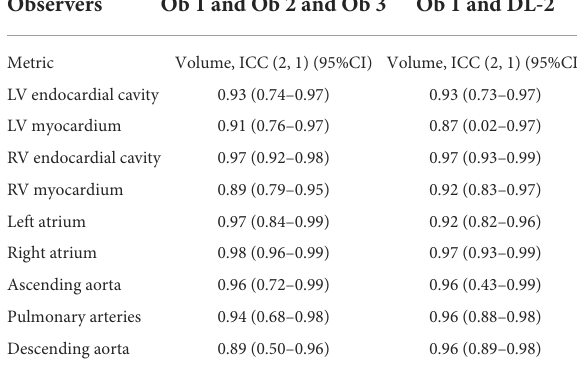
TABLE 3 Volume ICC statistics for the three observers and DL model 2 evaluated in the interobserver comparison cohort ( n = 24).